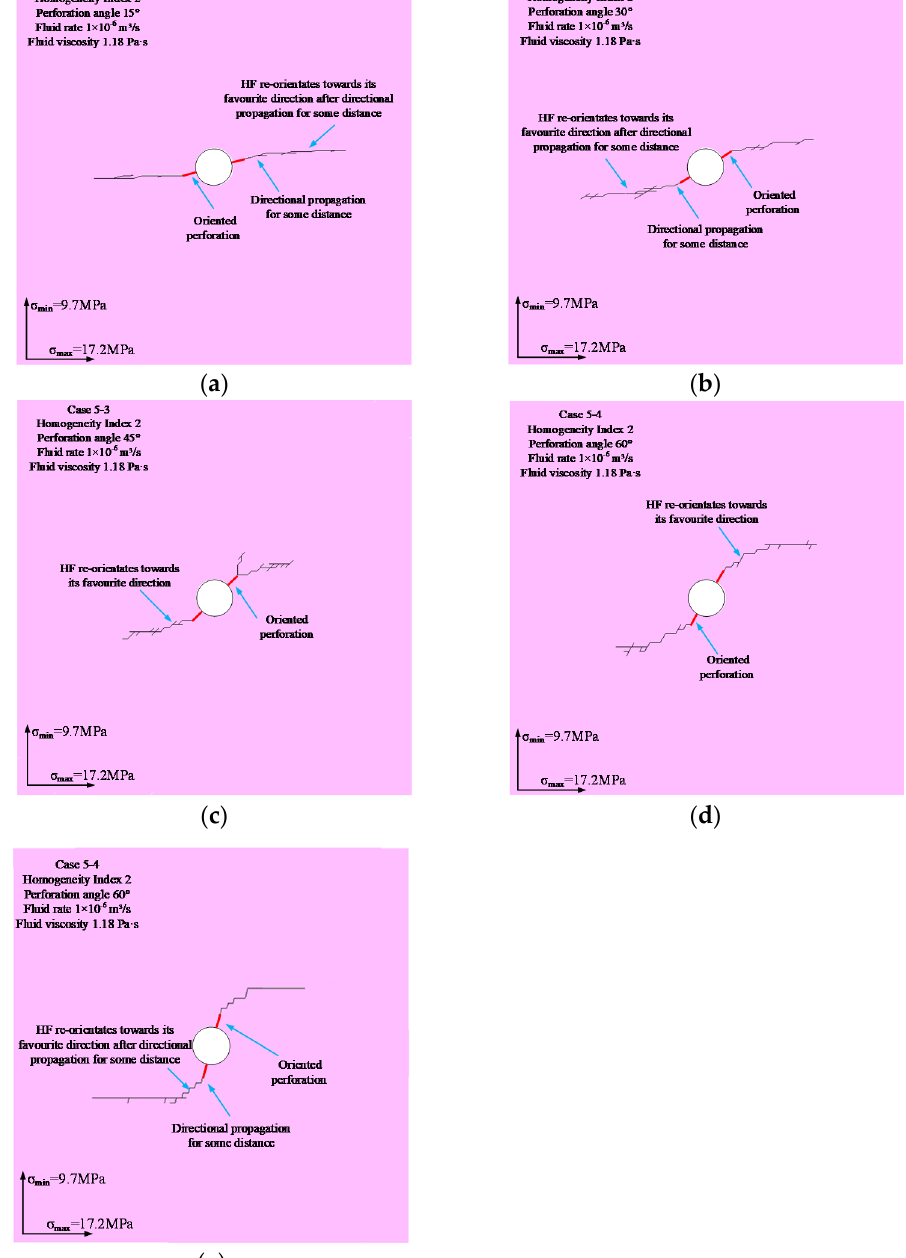
Figure 11. The relationship between HF re-orientation and perforation angle when the homogeneity index is 2: ( a ) perforation angle is 15°; ( b ) perforation angle is 30°; ( c ) perforation angle is 45°; ( d ) perforation angle is 60°; ( e ) perforation angle is 75°.